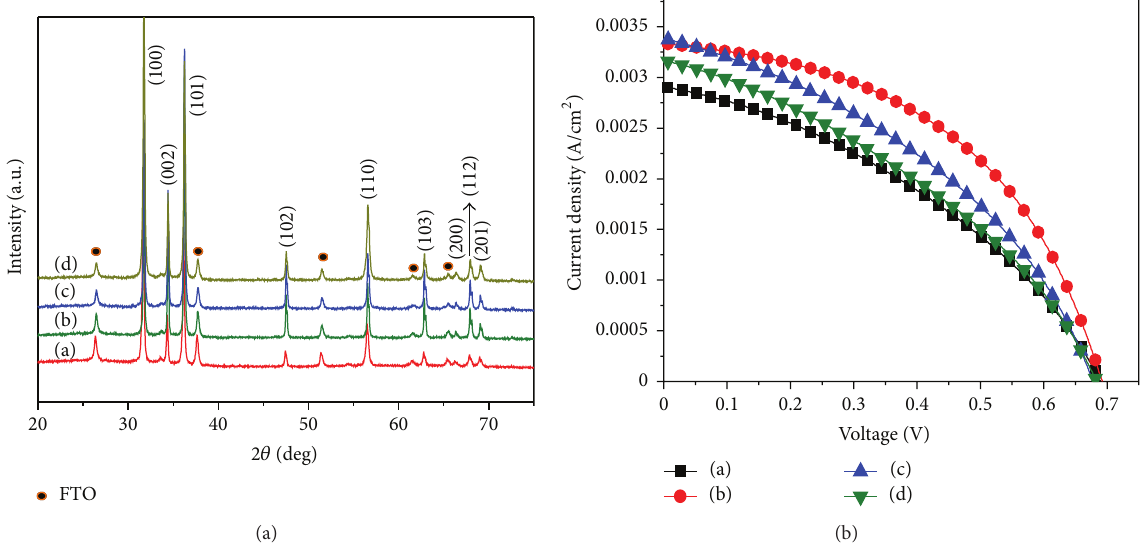
Figure 5: (a) XRD pattern of the ZnO films under different electrodeposition times. (b) J - V curves obtained from DSSCs under different electrodeposition times: (a) 2 min, (b) 3min, (c) 4min, and (d) 5